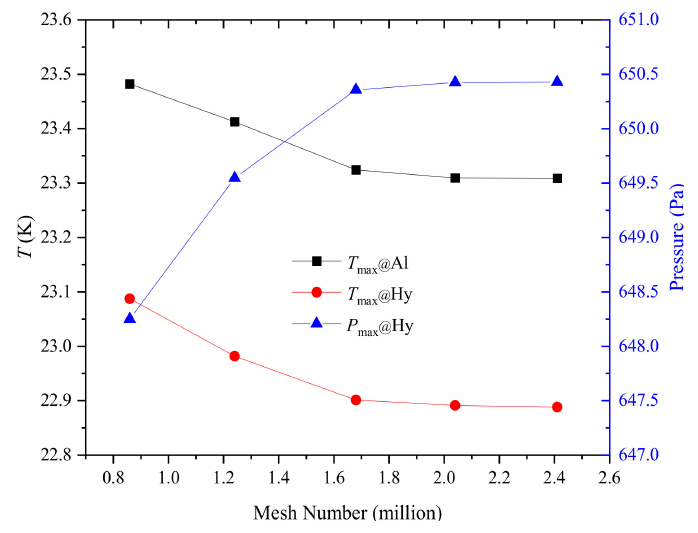
Figure 3. Grid independence validation of